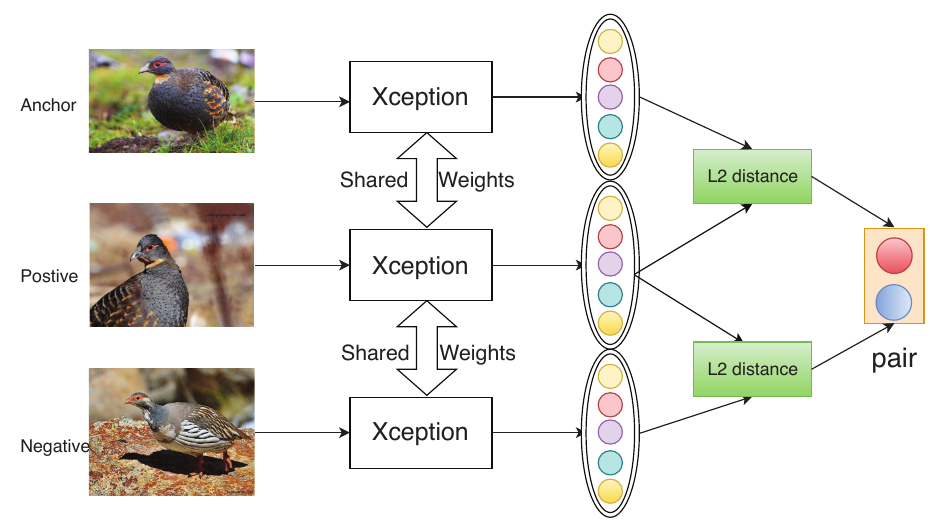
Figure 7. Structure of a triplet